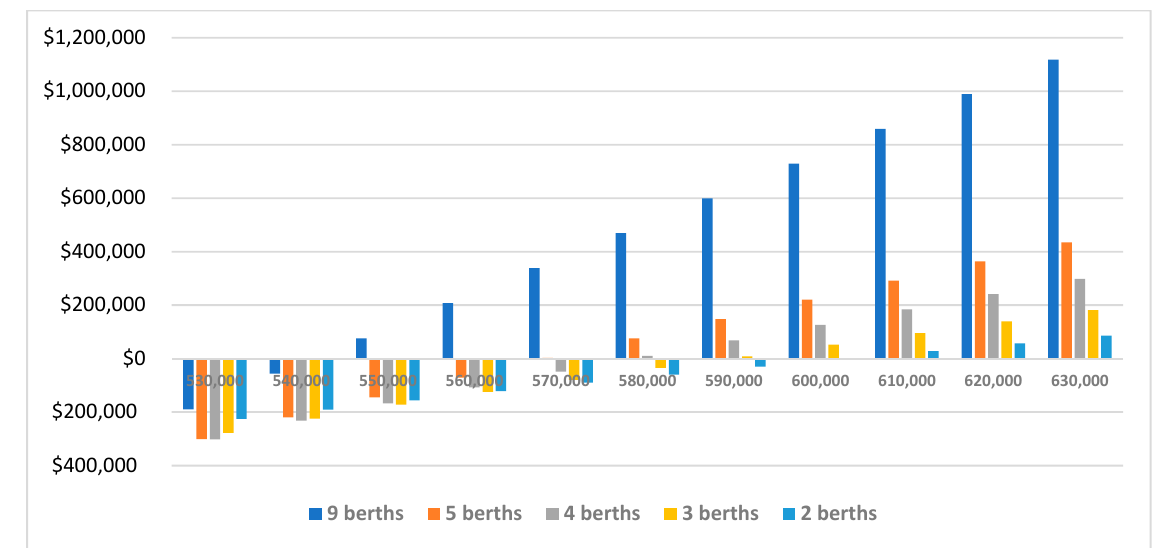
Figure 5. NPV changes per berth size in applying a 2.96% social discount ratio (Source: Author).